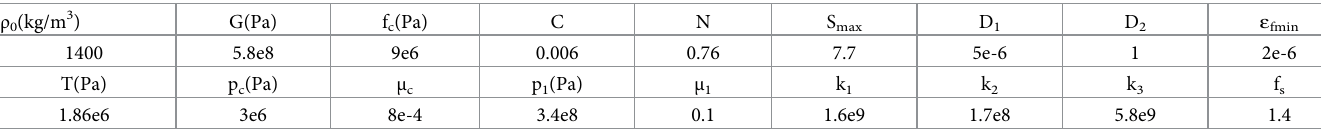
Table 3. HJC material model parameters of